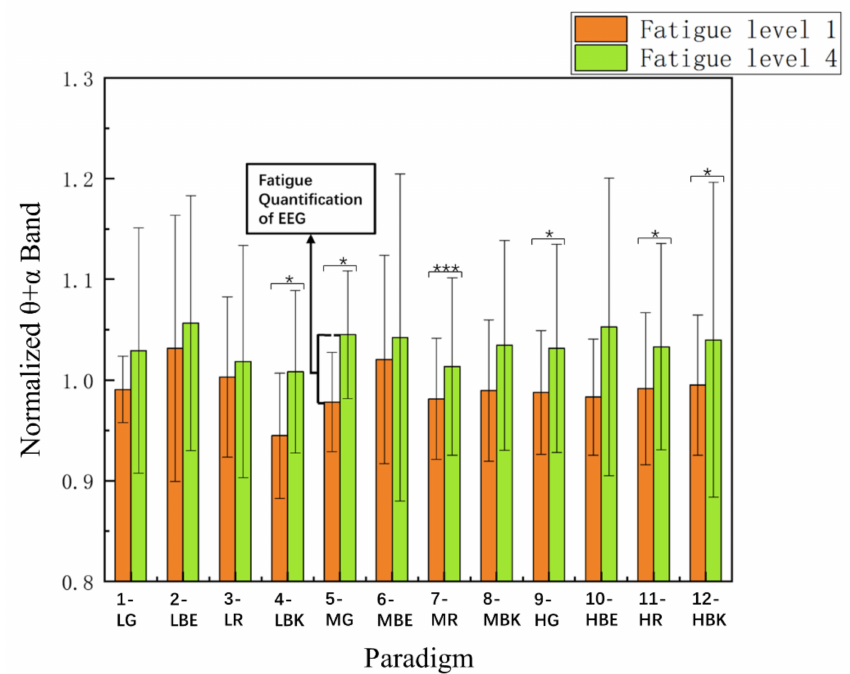
Figure 9. Comparison of the mean values and SD of normalized θ + α index between fatigue level 1 and fatigue level 4 for 12 stimulus paradigms over 15 subjects. Statistics were assessed by one-way repeated-measures ANOVA. *** p < 0.001; * p <